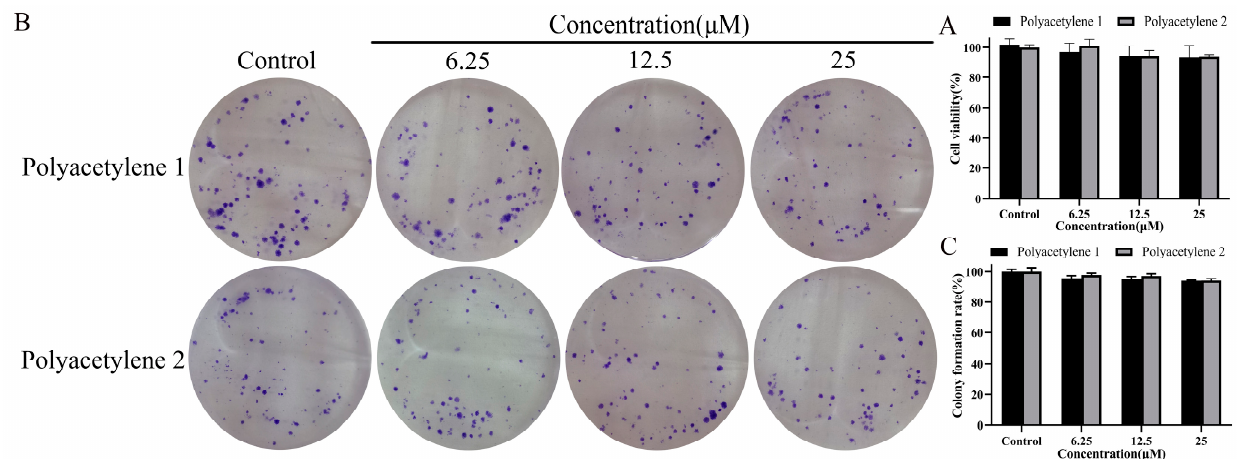
Figure 2. Determination of non-cytotoxic concentrations. ( A ) Cell viability of HGC-27 cells treated with 25, 12.5, and 6.25 µ M polyacetylenes 1 and 2 for 48 h as determined using an MTT assay. ( B ) Representative stained colony plates of HGC-27 cells treated with polyacetylenes 1 and 2 . ( C ) Colony formation rate of HGC-27 cells treated with polyacetylenes 1 and 2 . Results were expressed as the mean ± SEM (n = 3). No significant difference compared with the control group.